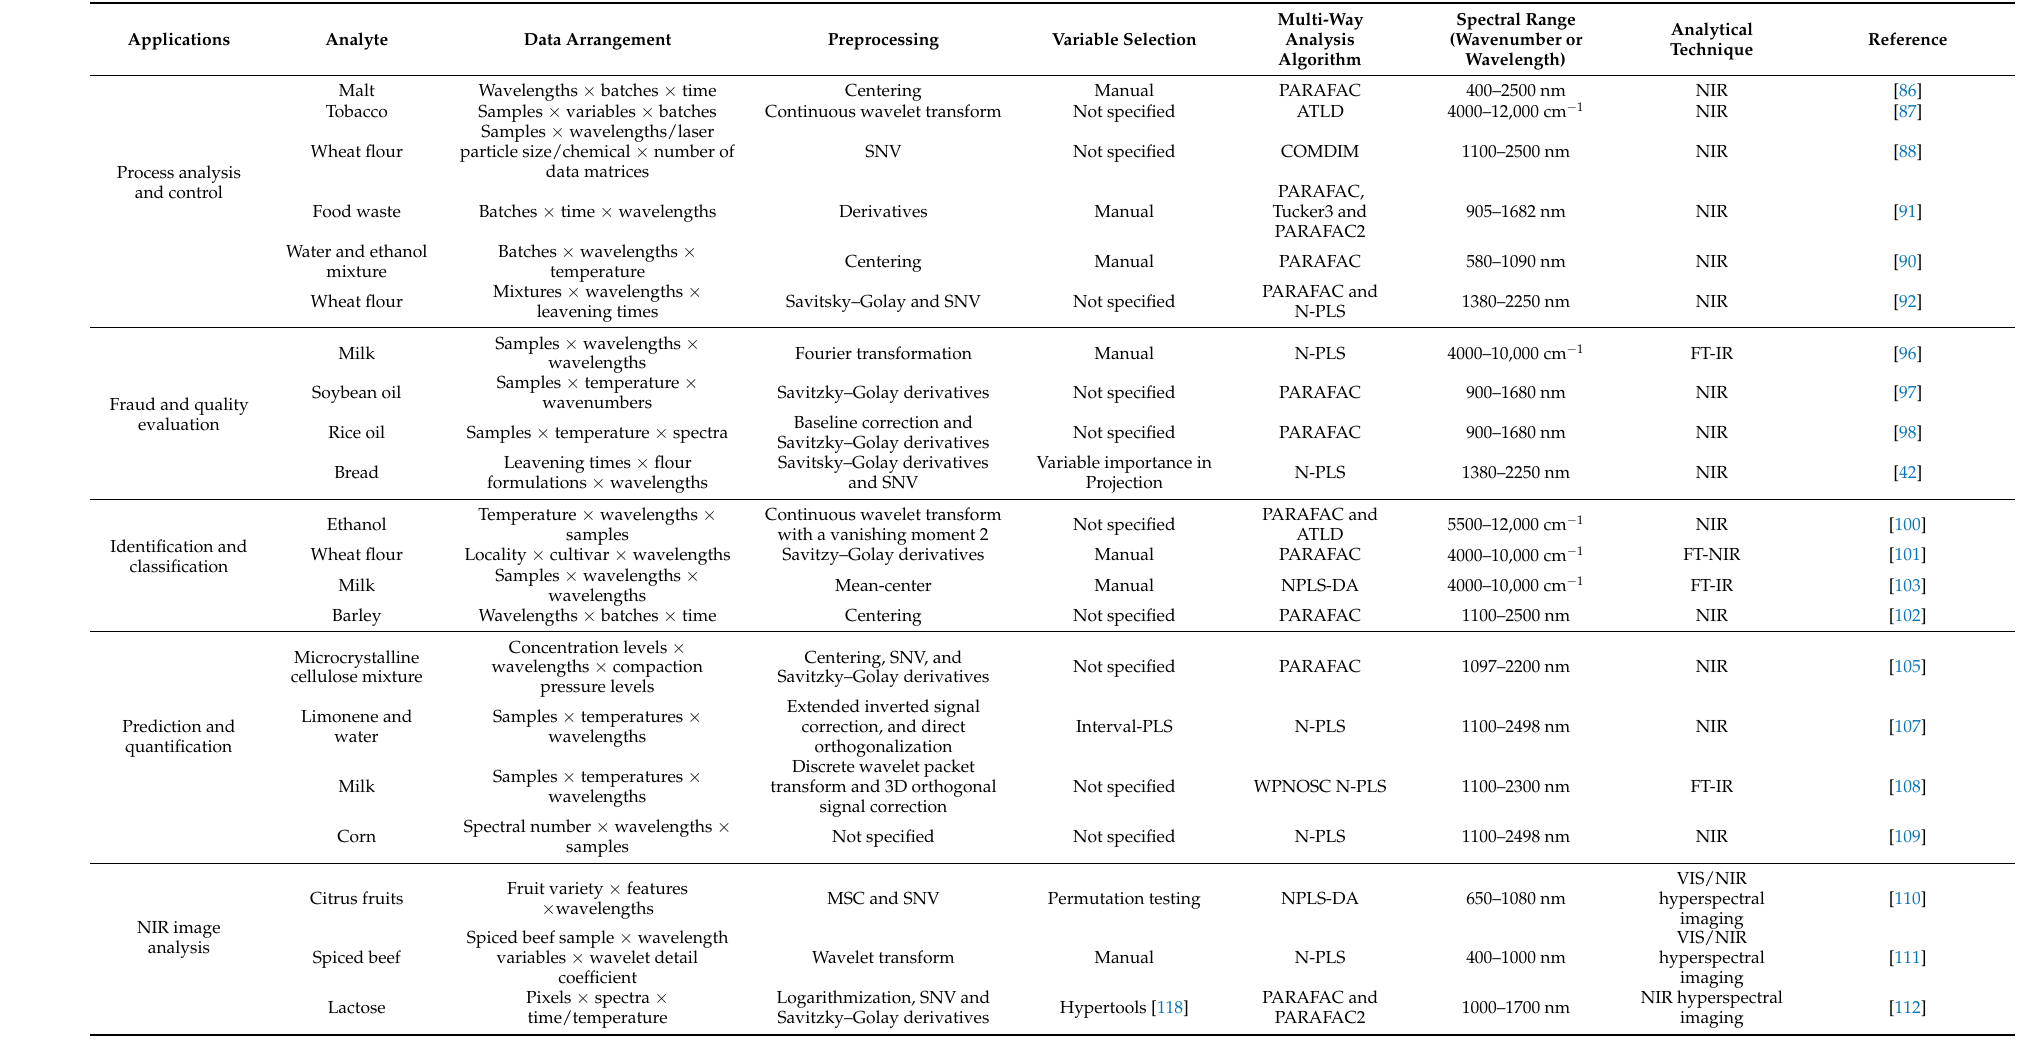
Table 2. Representative applications of multi-way analysis models coupled with near-infrared spectroscopy (NIRS) for analyzing food